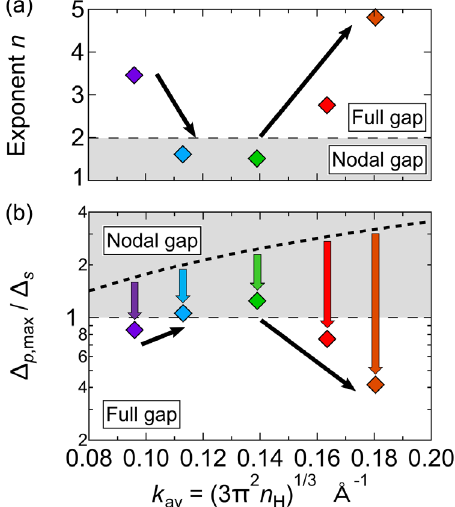
FIG. 4. Doping dependence of the penetration depth exponent and the septet gap component. (a) Exponent n in the power-law T n dependence of Δ λ ð T Þ as a function of the effective Fermi ¼ ð 3 π 2 n Þ 1 = 3 for the pristine (purple), 3.13 wave vector k av H (light-blue), 5.28 (green), 8.44 (red), and 11.61 (brown) C = cm 2 irradiated samples. The exponent n ≤ 2 (shaded region) indicates a nodal gap structure, while n > 2 implies a fully gapped state. j to the s -wave (b) Ratio of the p -wave septet component j Δ p; max component j Δ s j as a function of k . The black dashed line av ∝ k represents the relation Δ p; . The lengths of the colored max av vertical arrows are proportional to 1 = μ values [see Eq. (3)] in each sample. In the shaded region, a nodal gap structure is